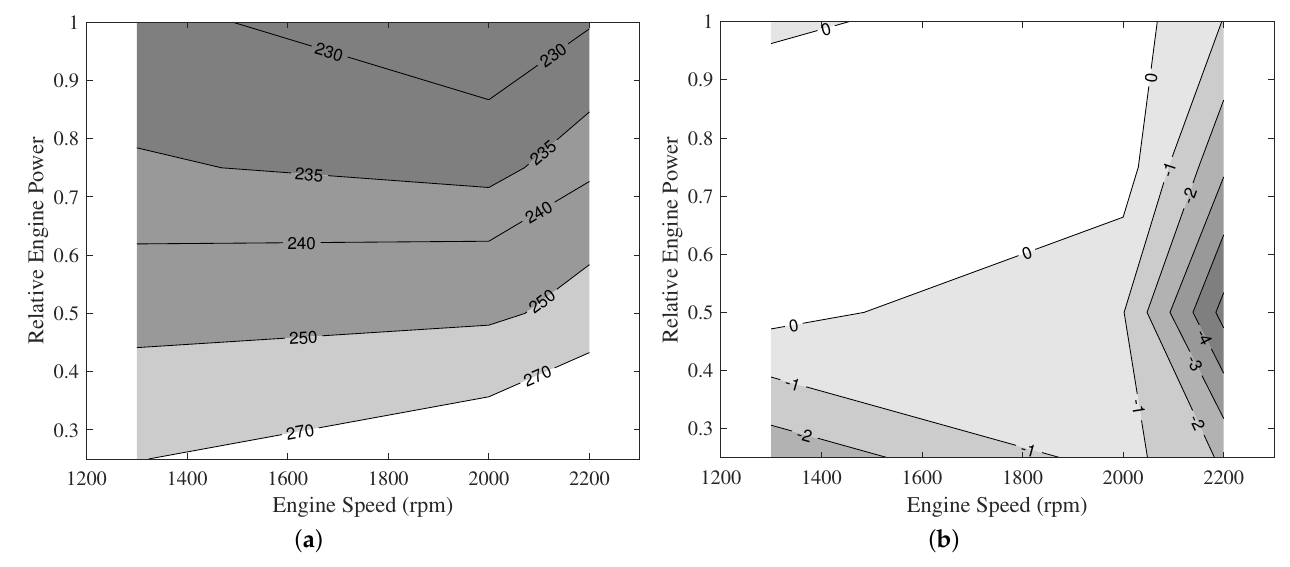
Figure 8. Results obtained from Iveco 8460 engine model. ( a ) Specific fuel consumption (g/kWh) map calculated by model. ( b ) Percentage differences between calculated and measured values of b e